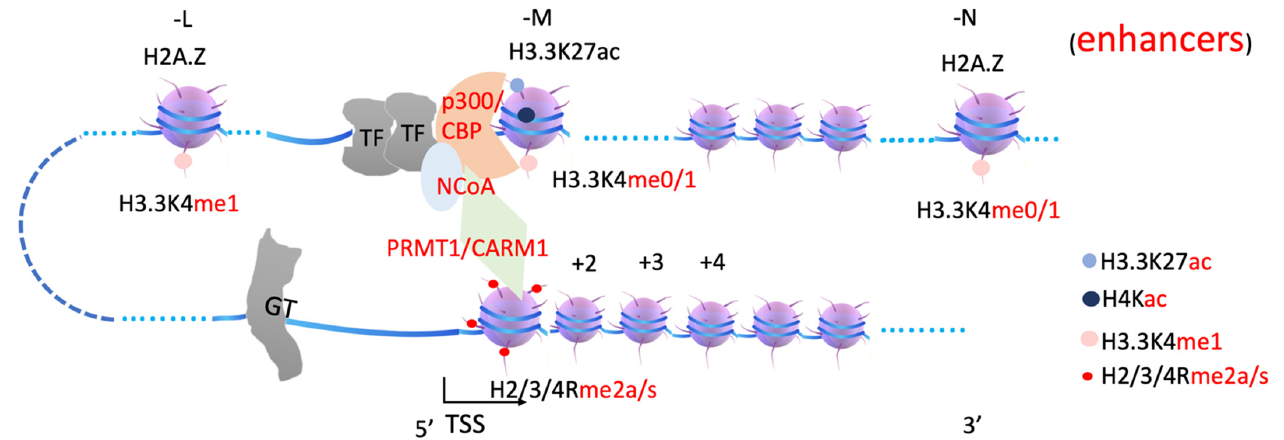
Figure 3. A model of transcription activation and arginine methylation on +1 nucleosome. A tran- scription unit includes enhancers, transcription factors (TFs), p300/CBP, nuclear receptor co-activator (NCoA), arginine methyltransferase 1 or 4 (PRMT1, CARM1), arginine methylated histone tails at +1 nucleosome. H3.3K27ac, acetylated H3.3 subunit; H4Kac, acetylated H4 subunit; H3.3K4me1, monomethylated H3.3K4; H2/3/4Rme2a/s, arginine methylated histone subunits H2, H3, and